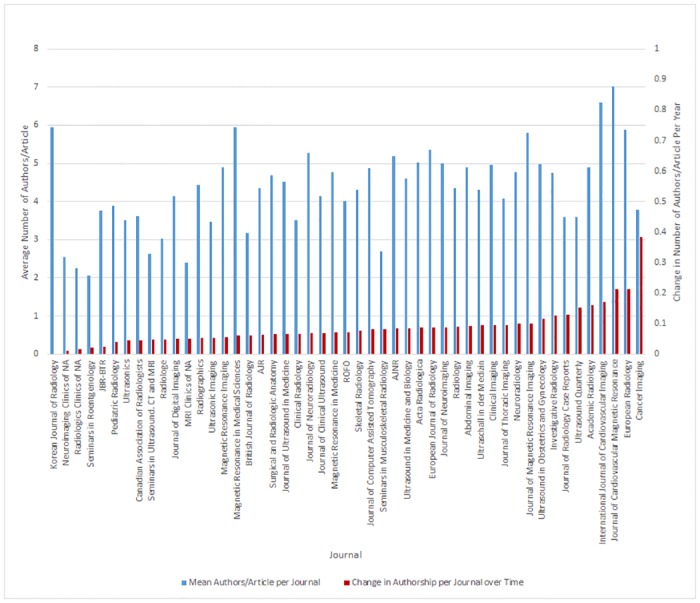
Mean Number of Authors/Article and Change of Authorship per Journal.This is a double axis bar chart showing the mean number of authors/article per journal and the overall change in authorship per journal over time. Journals were organized by change in authorship over time. All journals show an increase in the change in authorship over time with the exception of the Korean Journal of Radiology which has a -0.003 change of authorship per year.